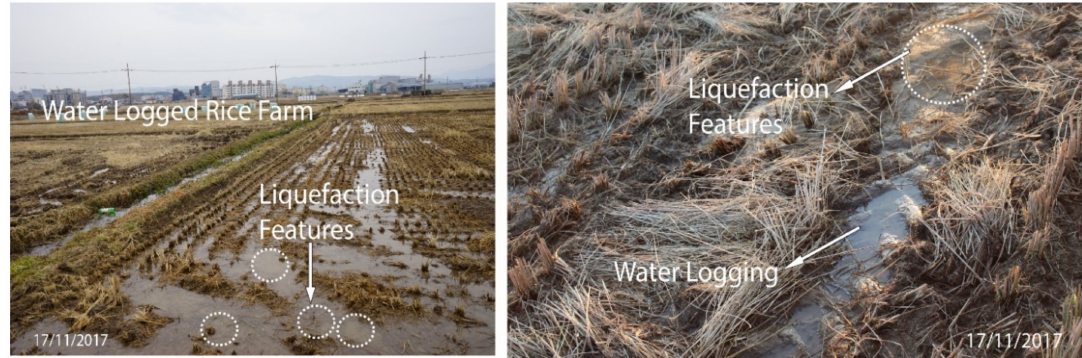
Figure 7. Field photographs showing evidence of waterlogging along the rice farms around Mangcheon-ri near the 2017 Pohang earthquake epicentral area soon after the